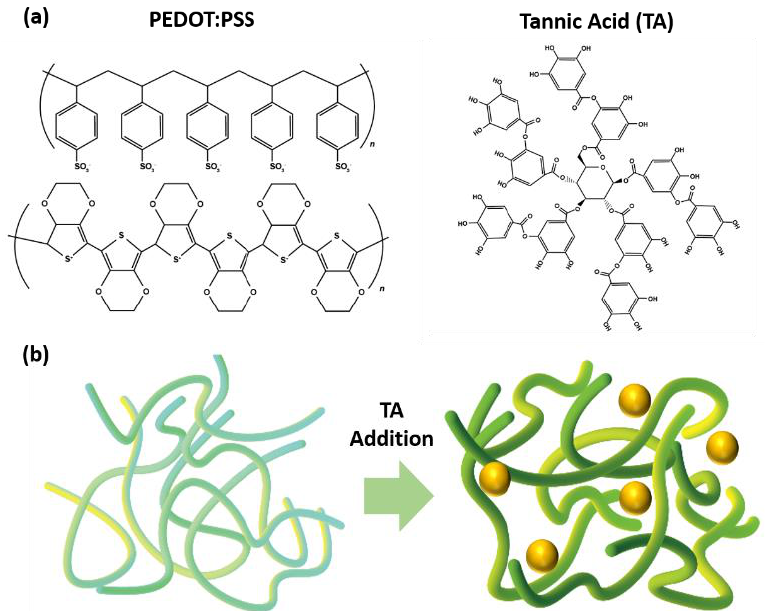
Figure 1. Chemical structures and effect of TA addition in PEDOT:PSS: ( a ) Structure of PEDOT:PSS and tannic acid, ad ( b ) changes of PEDOT:PSS via the addition of tannic acid. and tannic acid, ad ( b ) changes of PEDOT:PSS via the addition of tannic